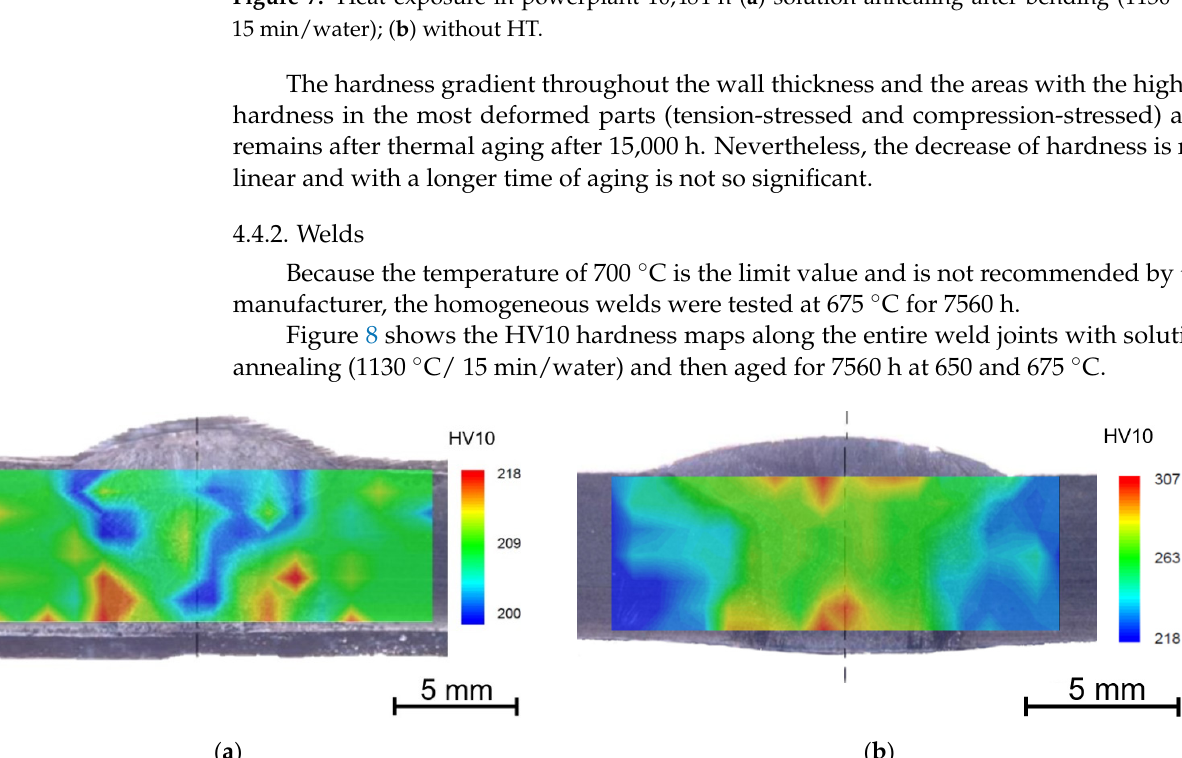
Figure 7. Heat exposure in powerplant 10 484 h ( a ) solution annealing after bending (1,130°C/15 min/water); ( b ) without HT.